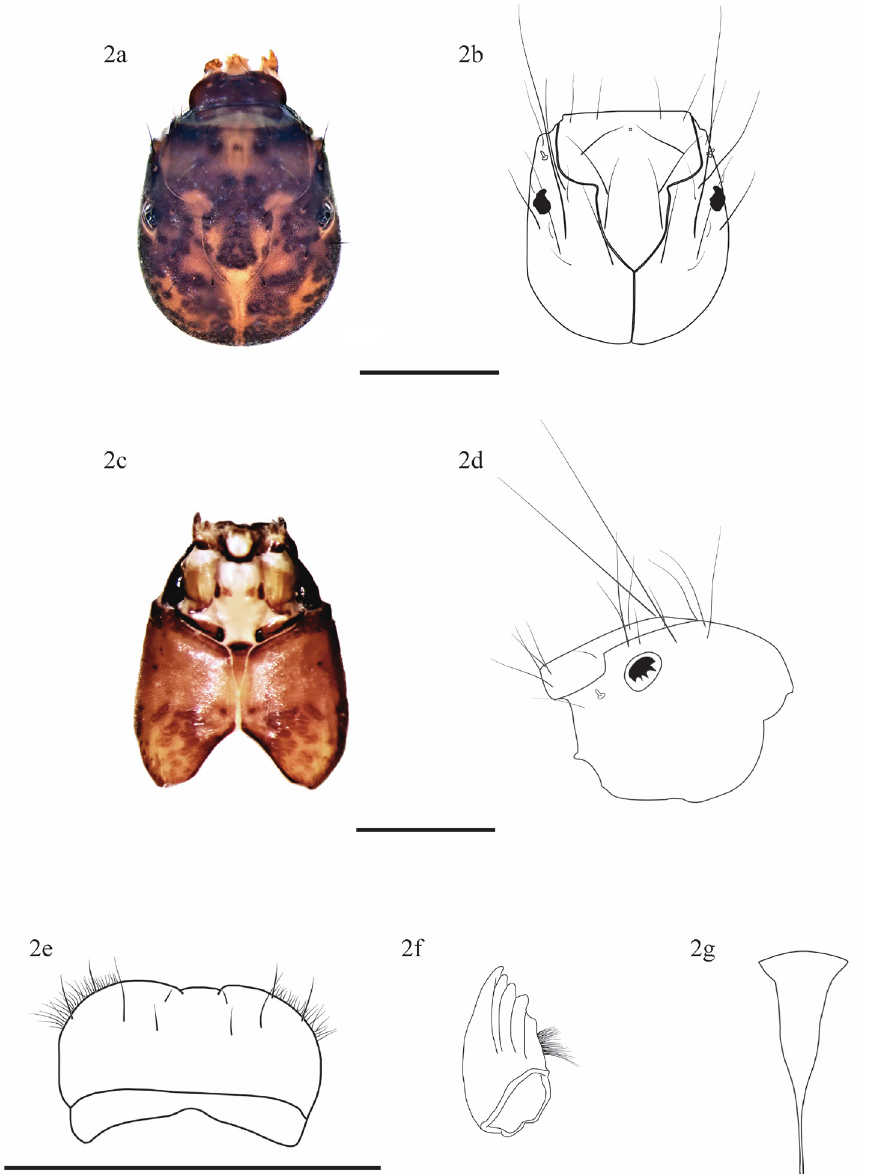
Midlegs. Coxa with 1ventro-distal long setae; ventral margin with 3 long setae and 4 medium sized setae, dorso-distal margin with 3 long and 4 medium sized setae in the external side, internally with 2; dorso-proximally with 3 long and 5 medium sized setae; external surface of the segment completely covered by minute spicules; the rest of the chaetotaxy as shown in figure 3d. Throchanter with 3 long, ventral